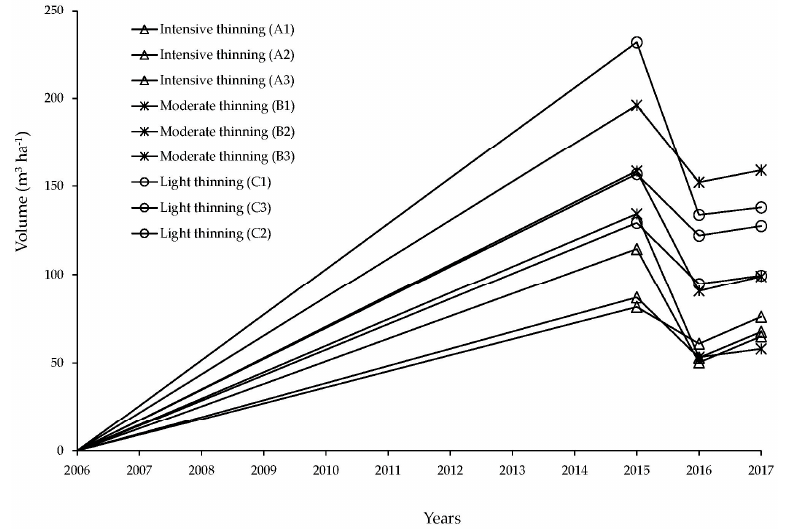
Figure 3. Volume evolution of laurel tree in thinning plots for the period 2006–2017, in traditional agroforestry systems in the Ecuadorian Amazon upper basin.